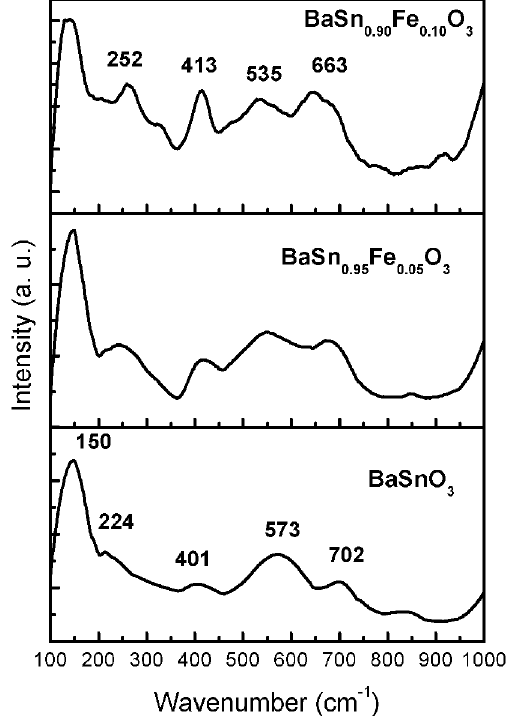
Fe O (0; 0.05 and 0.1 in mol) 1-x x 3